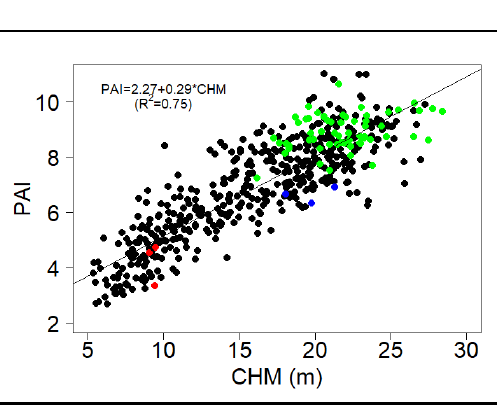
Figure 6. Relationship between the PAI estimated from the LiDAR and past time after disturbance (grey dots). The red line represents the fitted power model. Red dots represent the PAI of SIS in successional sample plots. Blue dots represent PAI of SES in successional sample plots. The box plots